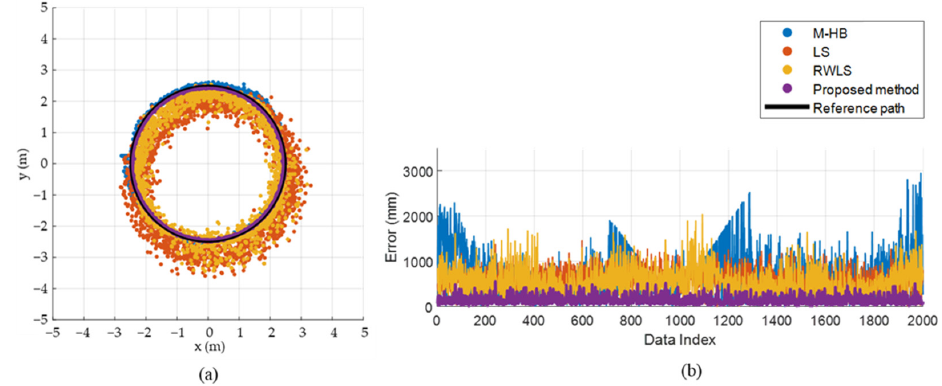
Figure 11. Comparison of estimation accuracy between the proposed method and previous methods for the circular path: ( a ) comparison of estimation results, ( b ) comparison of estimation error.